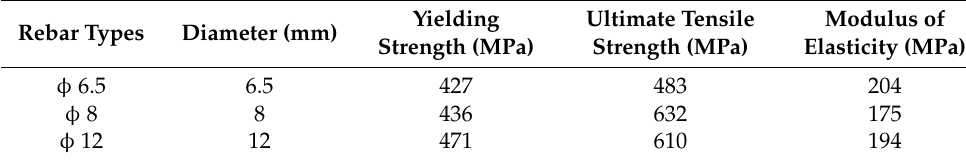
Table 2. Material parameters of steel rebars [21,23,33].